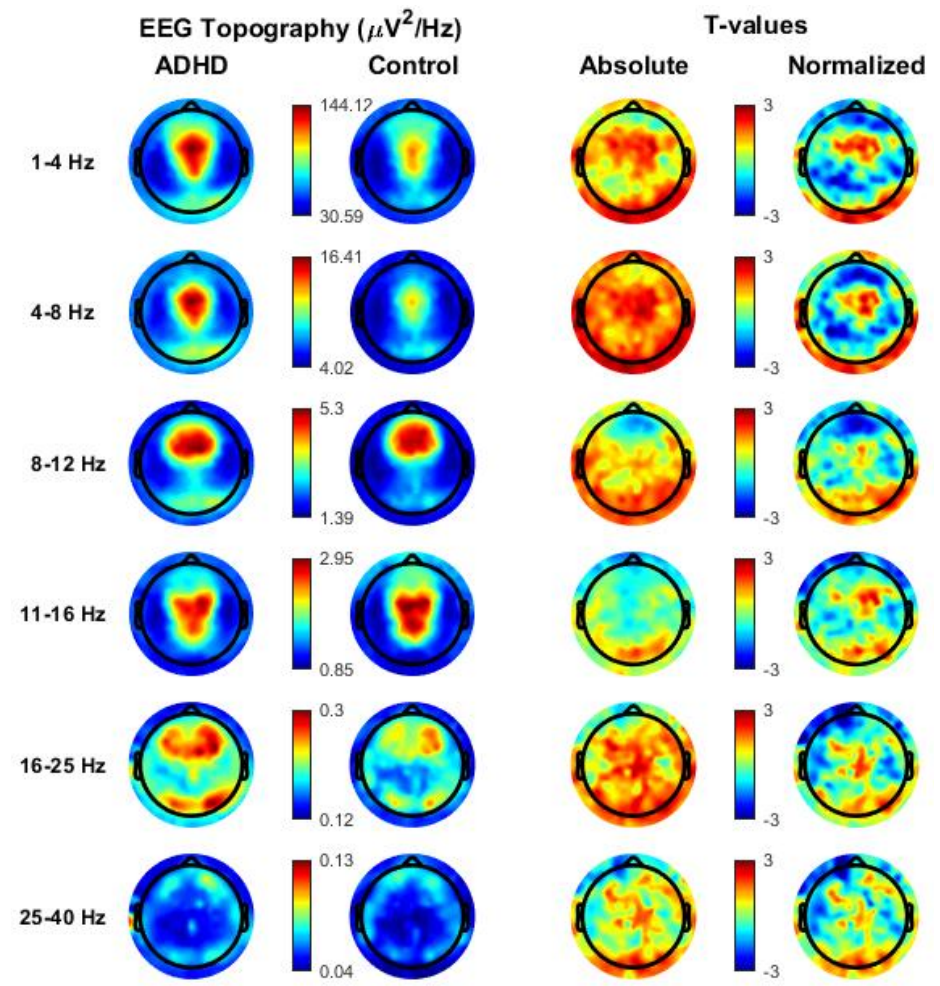
Figure 1. Topographical distribution of all frequency bands based on whole-night non-rapid eye movement (NREM) sleep stage 2 (N2) in the attention-deficit/hyperactivity disorder (ADHD) group and in the healthy control group. Values are color-coded and plotted on the planar projection of the hemispheric scalp model. Rows: frequency bands of interest. First and second column: average N2 sleep EEG topographies across frequency bands for children with ADHD and healthy control matches, respectively. Maxima are shown in red, minima in blue. Third and fourth column: single electrode t -value (2-tailed, unpaired) maps for the comparison between patients with ADHD and control sub- jects in terms of absolute and normalized (using the z-score across all electrodes) power, respectively. Blue color: decrease in EEG power in patients with ADHD relative to healthy controls (ADHDs < controls), red color: increase in EEG power in patients with ADHD relative to healthy controls (ADHD > controls). White circles indicate significant electrodes ( p < 0.05 cluster-size